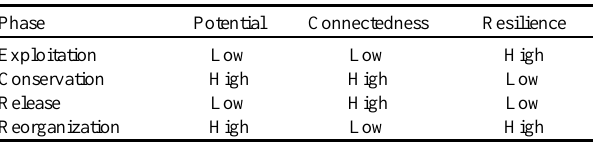
Table 1 . The level of potential, connectedness, and resilience